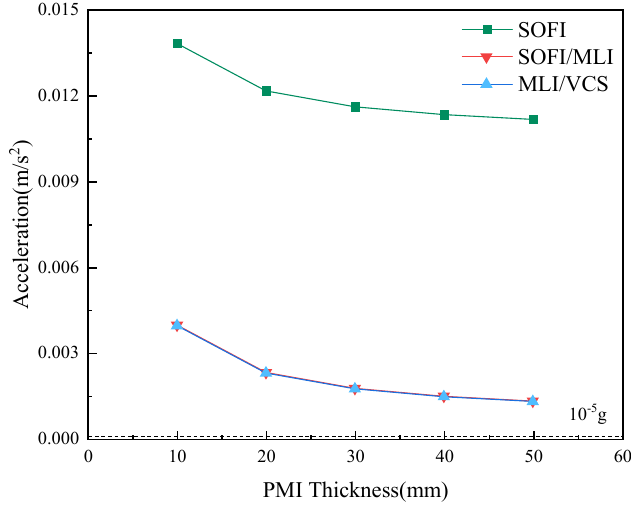
Figure 11. The forward thrust acceleration generated by exhaust is over 1.3 × 10 − 3 m/s 2 . Therefore, the acceleration generated by TVS exhaust can achieve e ff ective propellant con- Therefore, the acceleration generated by TVS exhaust can achieve effective propellant control. trol.